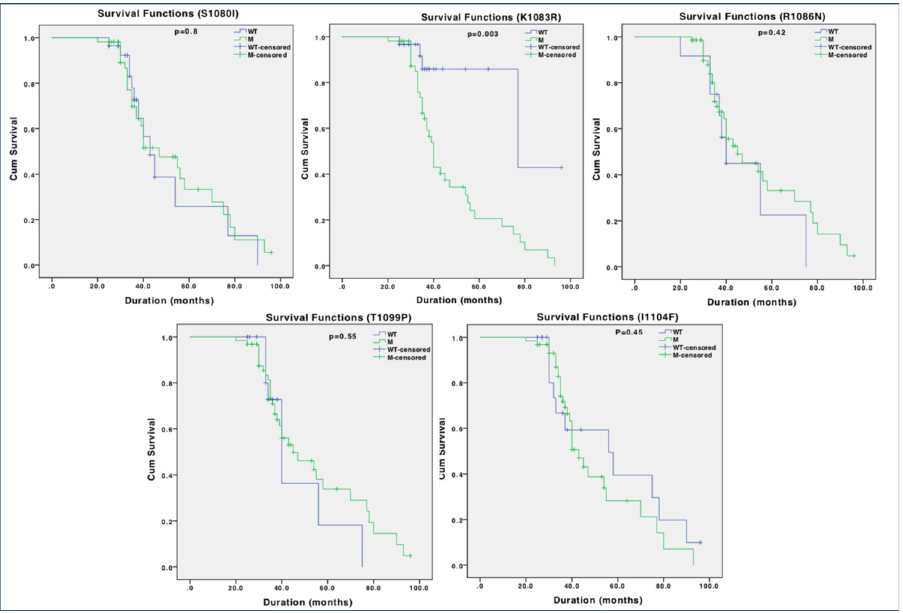
Fig 4. Survival analysis of Rbl2/p130 C-terminus mutations in breast cancer. Individual panel represents survival curve calculated through Kaplan Meier analysis for S1080, K1083, R1086, T1099 and I1104 mutations. Among all the five mutations, patients with K1083R mutation exhibited poor survival